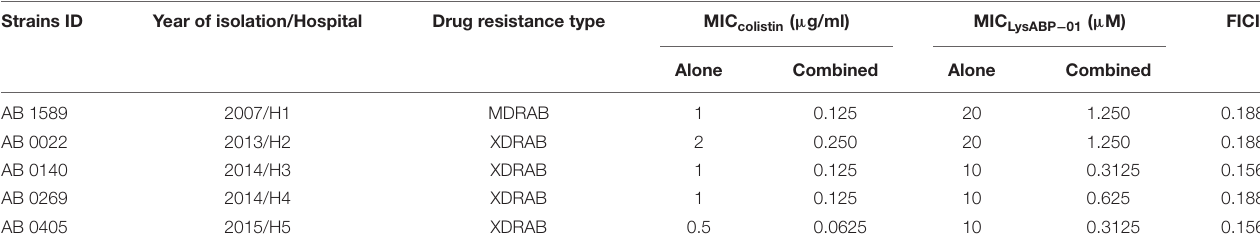
TABLE 2 | Characteristics of clinical A. baumannii strains and their susceptibility to the LysABP-01 alone and in combination with colistin. Strains